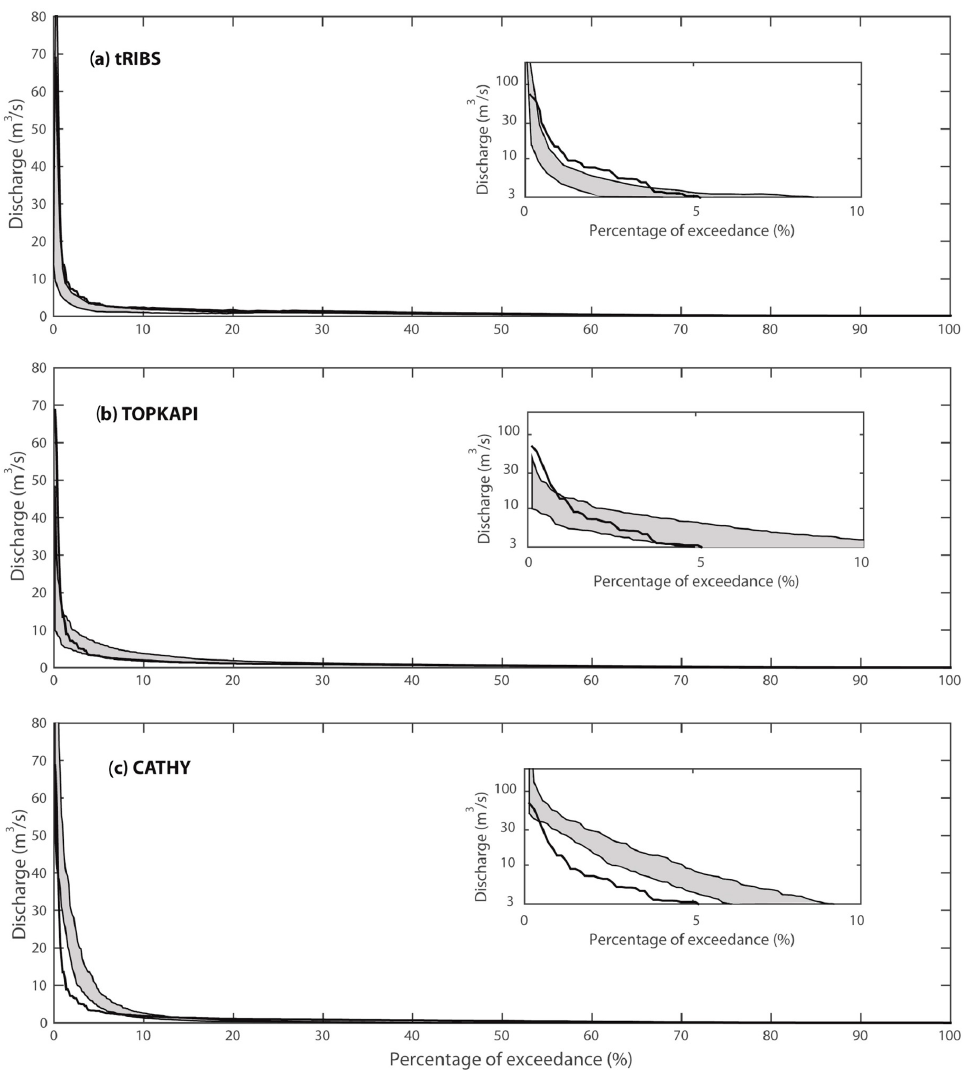
Table 7. As Table 6, but for the 1931–1932 simulation period (validation period for tRIBS). For the CATHY model an hypothesis of soil crusting was assumed.